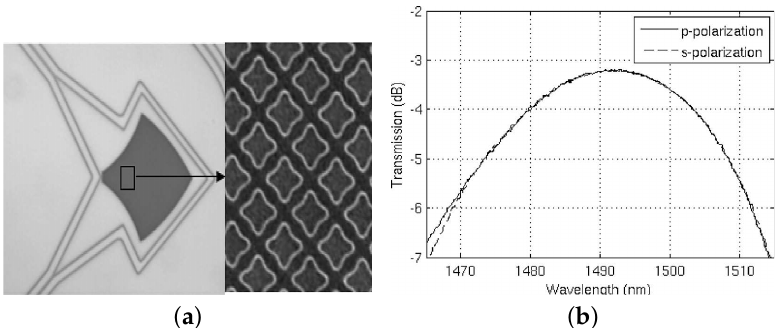
Figure 15. ( a ) Complex scatterers for better polarization tolerance. ( b ) Experimental results for coupling fundamental TE mode in either waveguide for the two polarization states (Images reprinted with permission from [54]).